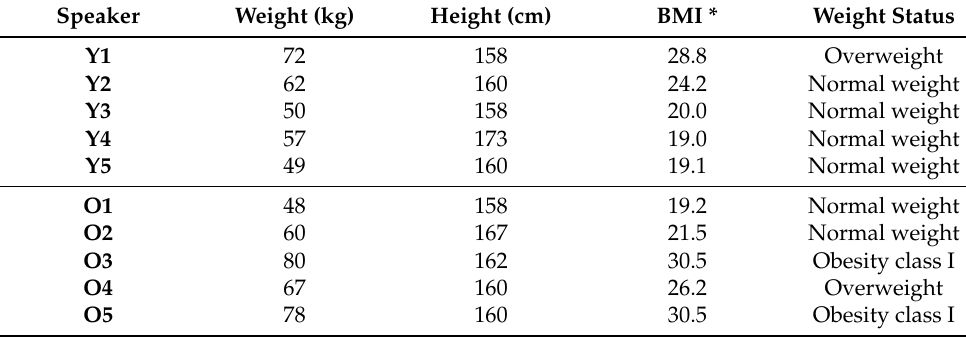
Table 1. Speakers’ anatomical characteristics.